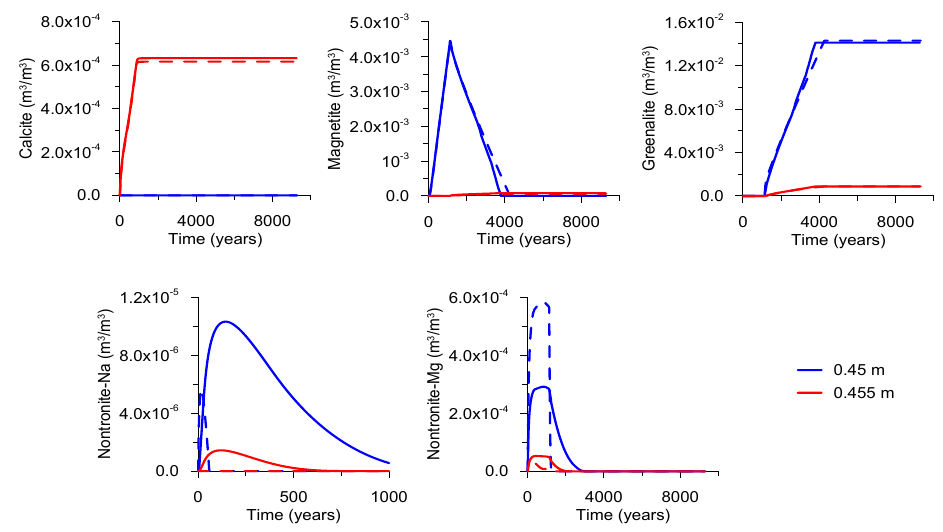
Figure 9. Evolution of the volumetric fraction of the secondary phases of the model with a low reactive surface area ( σ = 0.1 m 2 /m 3 , continuous lines) compared with the reference model ( σ = 1000 m 2 /m 3 , dashed lines). Results of the node at the interface (0.45 m) and the node right after the interface (0.455 m) are